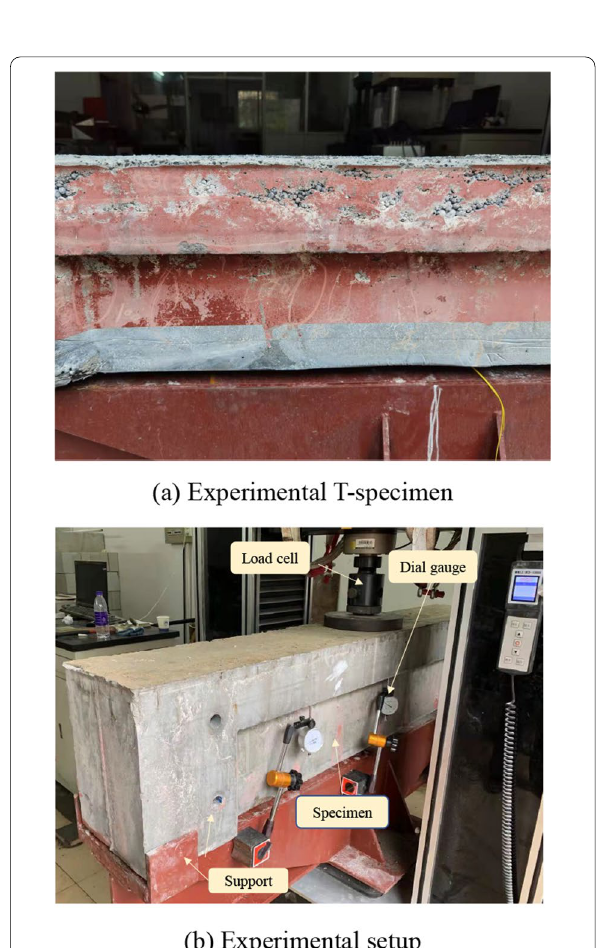
Fig. 2 Specimen loading. a Experimental T-specimen. b Experimental